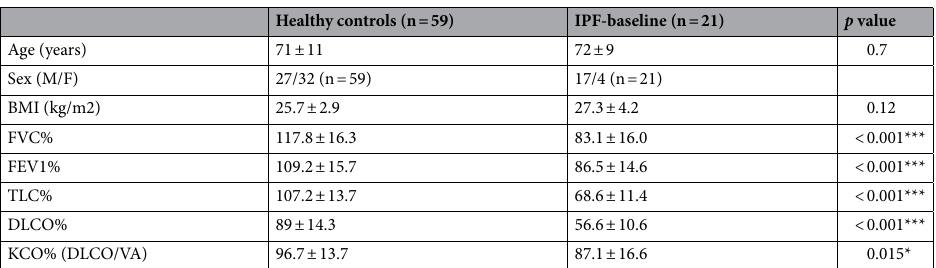
Table 1. Demographic and physiological data for IPF and controls. Percent predicted values are given for FVC (forced vital capacity), FEV1 (forced expired volume in one second), TLC (total lung capacity), D L CO (diffusion capacity for carbon monoxide), and KCO (carbon monoxide transfer coefficient). Data are given as mean ± standard deviation. Independent t-test p values indicated by: *(significance at the 0.05 level), **(significance at the 0.01 level), ***(significance at the 0.001